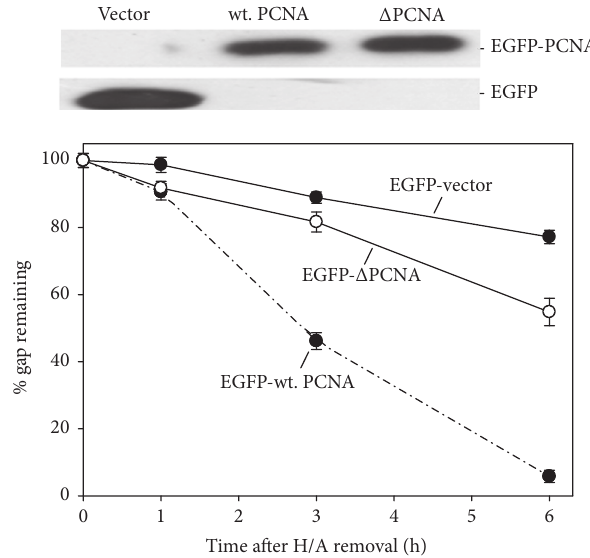
Figure 2: Top: western analysis of PCNA protein levels in total cell extracts of the CL1-0 cells stably transfected with wild type PCNA (EGFP-wt. PCNA) or truncated PCNA (EGFP- Δ PCNA) expression plasmids or EGFP-vector alone. Bottom: overexpression of PCNA attenuates colcemid-caused delay of gap-filling. CL1-0 cells stably transfected with the indicated plasmids were treated with the procedures illustrated in Figure 1 for studying the effect of PCNA overexpression on colcemid-caused delay of gap-filling during repair of UV-induced DNA